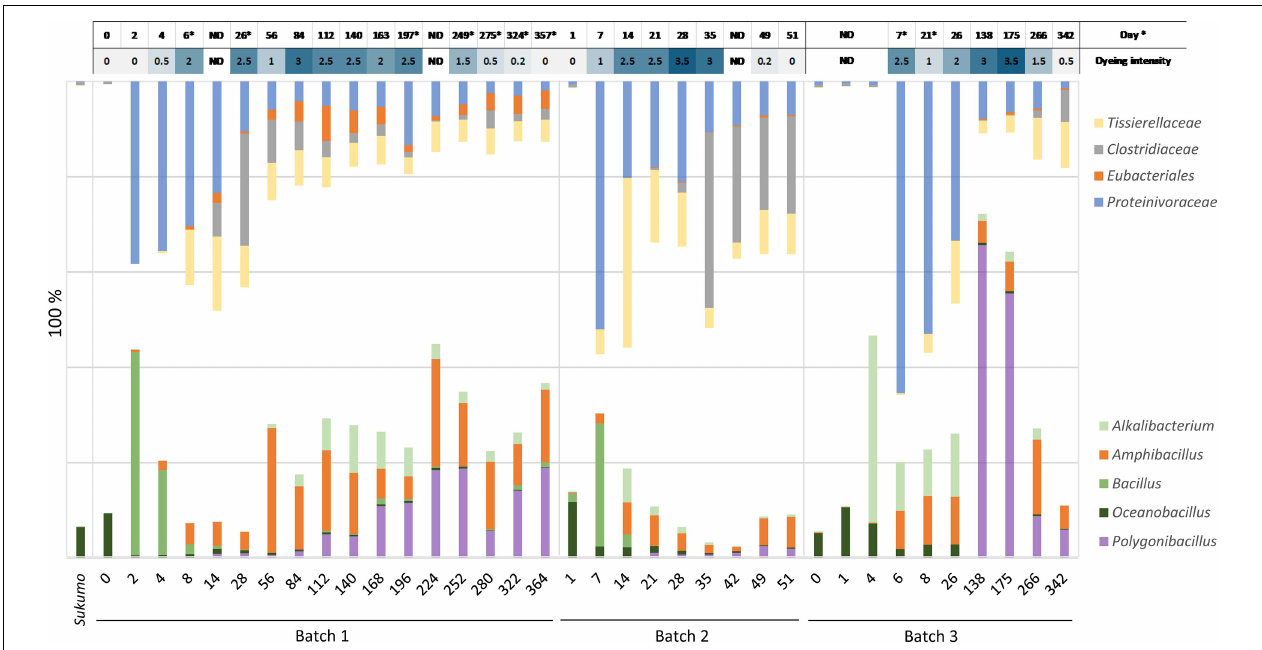
FIGURE 2 | Relationship between dyeing intensity and abundance ratio changes in known facultative anaerobic or aerotolerant indigo-reducing bacteria (lower side), and in obligate anaerobes (upper side) including the indigo-reducing Tissierellaceae . ND: no data; * The dyeing date was different from the sampling date for analysis of bacterial